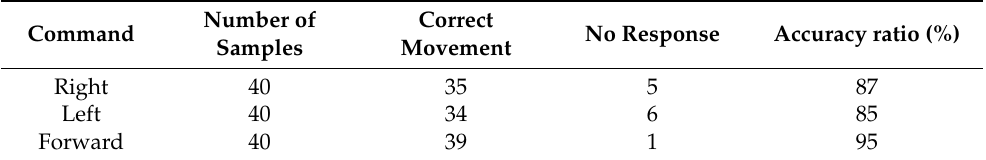
Table 3. Repeatability commands for biobots.